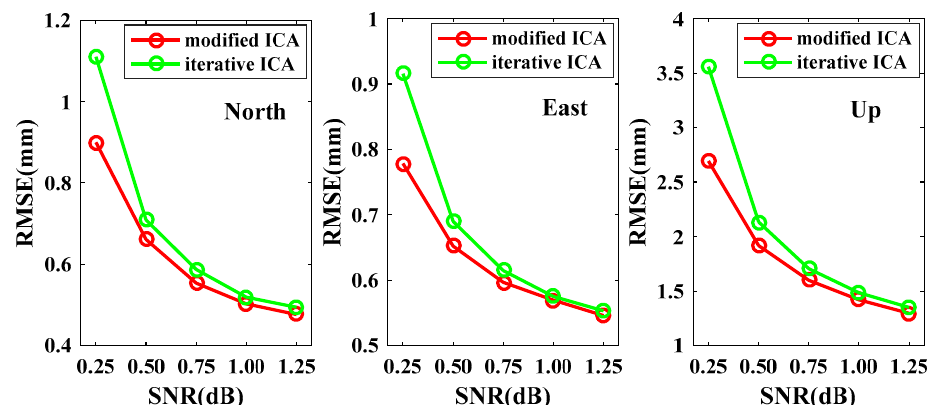
Figure 12. The mean RMSEs of modified ICA and iterative ICA for different SNRs.